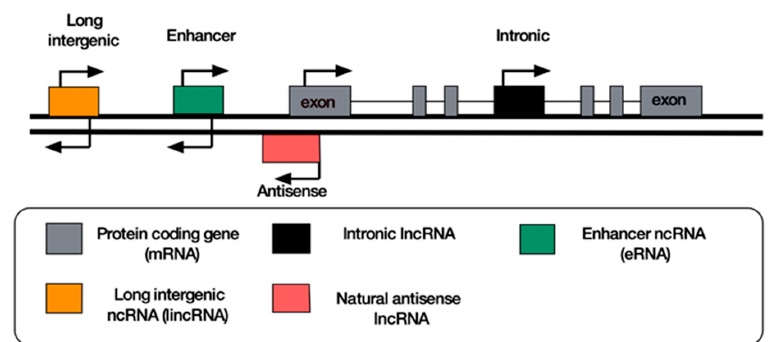
Figure 1. Classification of the most widely found lncRNAs according to their genomic location. Attempts to resolve the transcriptomic complexity of lncRNAs have led to their classification based on their genomic proximity to protein coding genes (mRNA). LincRNAs and eRNAs are stand-alone transcription units situated near protein coding genes. Intronic lncRNAs are found within the introns of protein coding genes, while antisense lncRNAs are transcribed from the opposite strand from the exonic regions of protein coding